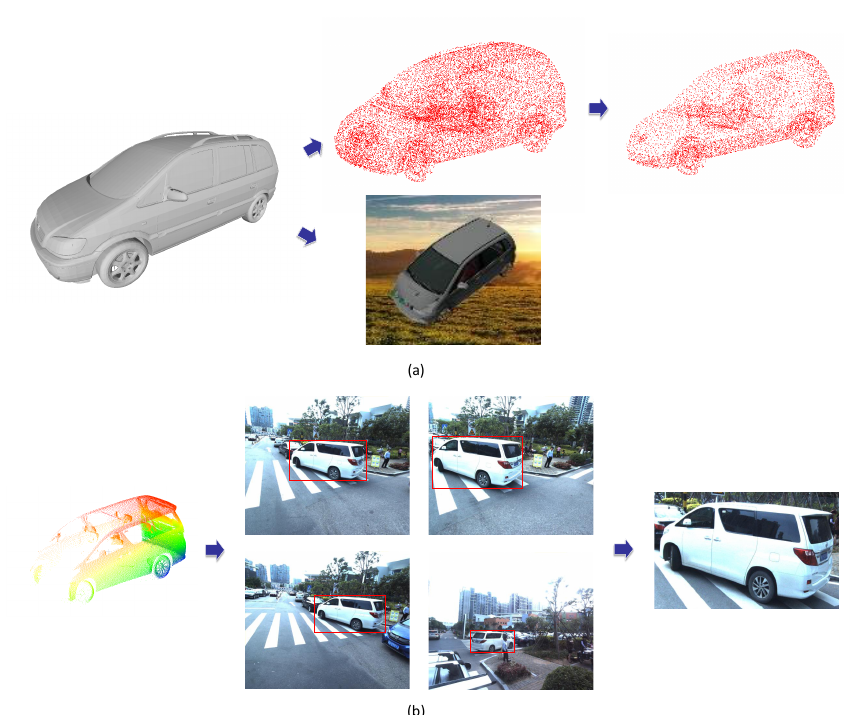
Figure 4. The component of our MLS system.